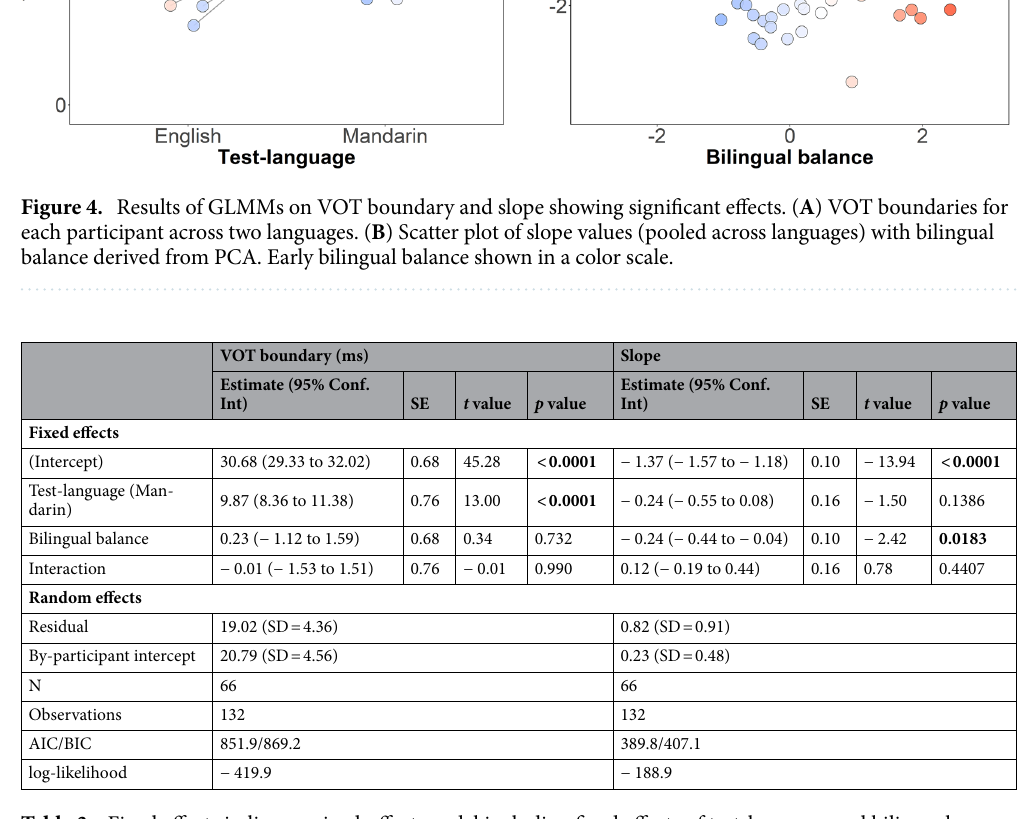
Table 3. Fixed effects in linear mixed-effect model including fixed effects of test-language and bilingual balance, and random effects of participants (random intercept) for VOT boundary (Left) and slope (Right). Larger t value in the GLMM for VOT boundary indicates a later threshold (ms) in the VOT continuum. Smaller t value in the GLMM for slope value indicates a shallower slope of the phoneme identification curve. Significant values are in